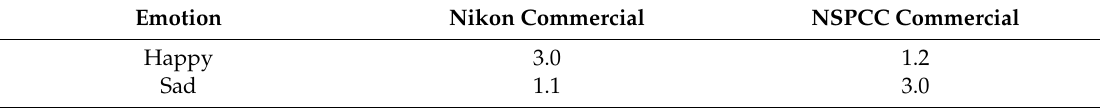
Figure 5. Three-point moving averages of facilitation indices for the Joy word set whilst viewing the Nikon commercial. Positive scores indicate positive affect, negative scores indicate negative affect. A brief description of the content is shown at various points in time. Analysis indicated that the facilitation indices at the points 16 and 44 − 48 are significantly different from zero (in each case p < 0.05). Table 3. Explicit responses: emotion ratings for both